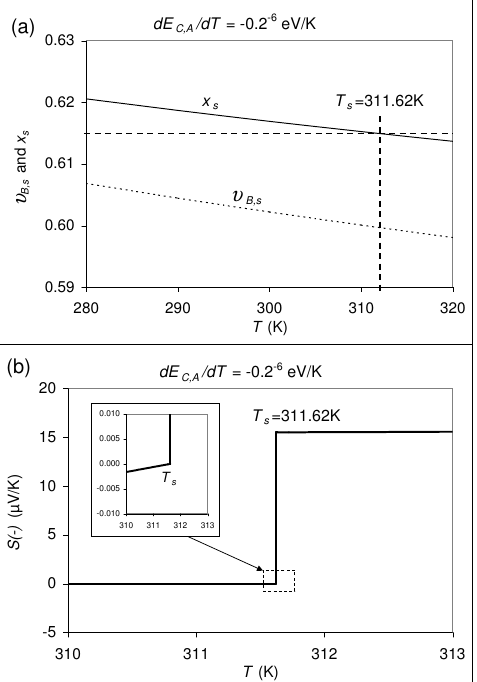
dE C,A /dT = -0.2 -6 eV/K